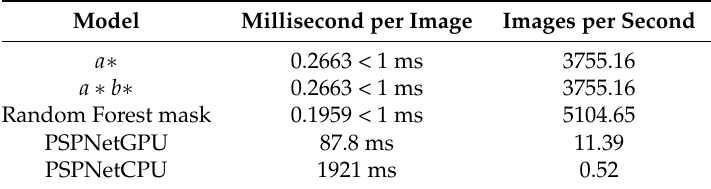
Table 3. Computing performance comparison of competing approaches to classify vegetation pixels in Mapillary